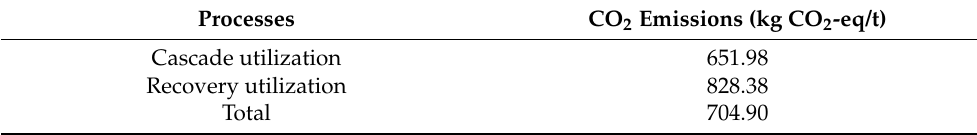
Table 9. GHG savings from the recycling process for waste LIBs.